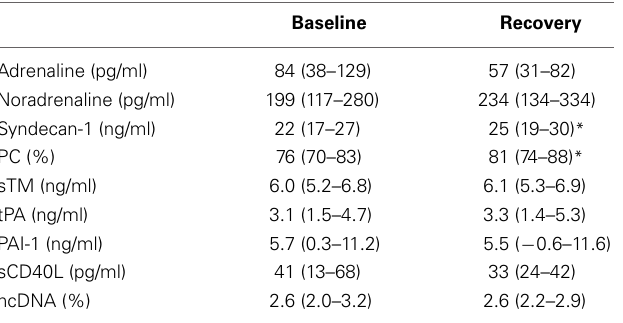
FIGURE 1 | EndoPAT reactive hyperemia index (RHI) at baseline ( n = 11), hypoxia (4500m for 2–4h, n = 7), and recovery ( n = 12). Data are presented as means with 95% confidence intervals. ∗ p = 0 . 008 compared with